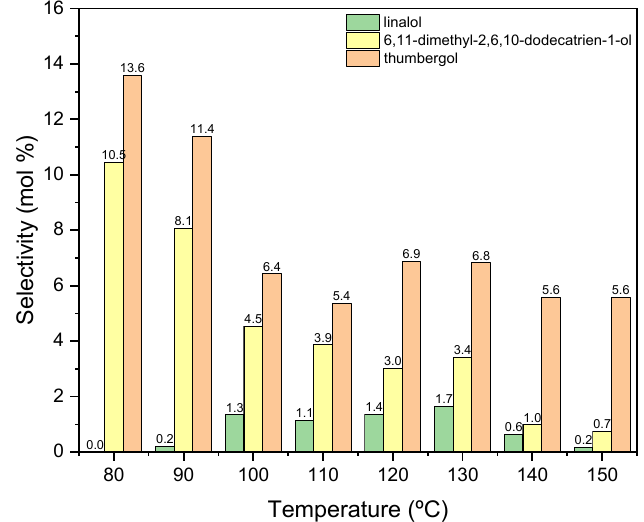
Figure 9. The influence of temperature on the selectivities of the appropriate products over aluminium potassium alum as the catalyst.